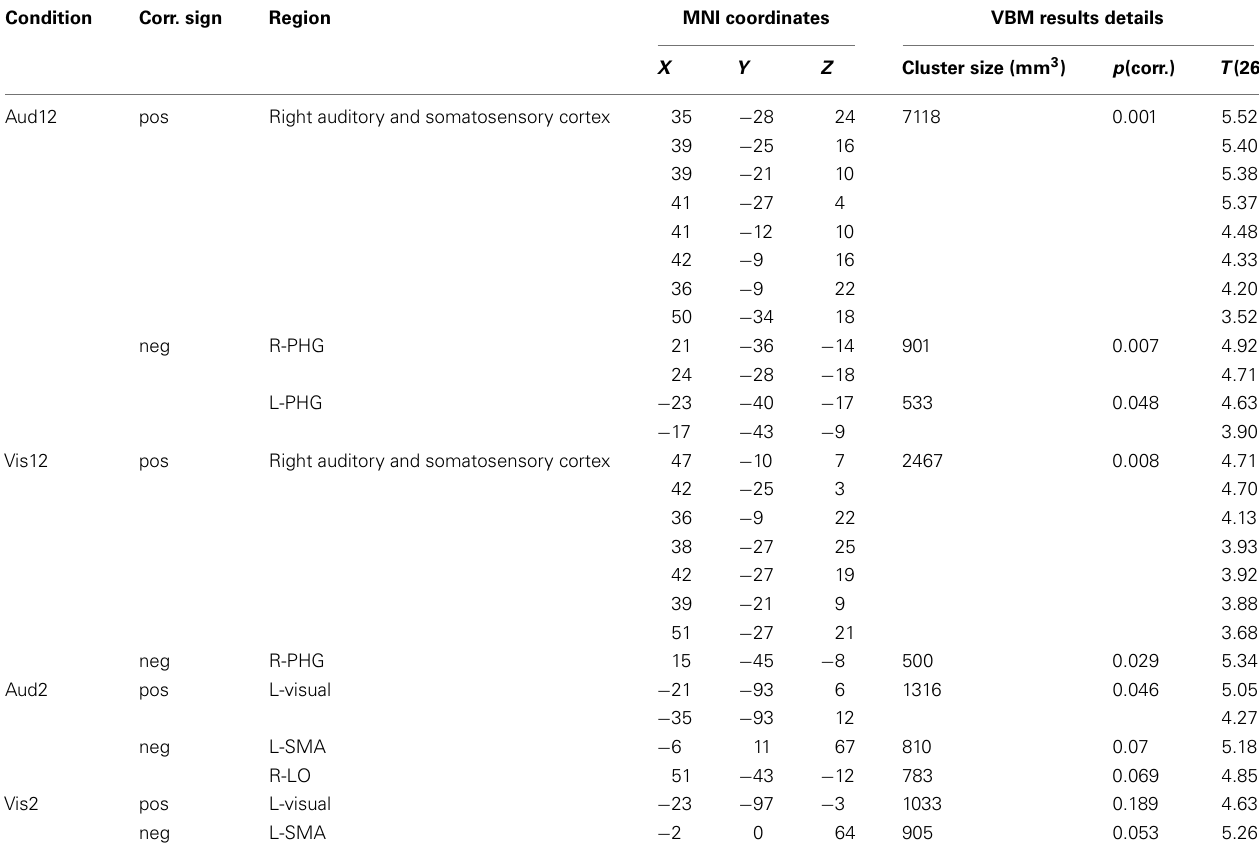
Table 1 |Anatomical and statistical details of the brain regions where gray matter volume correlated significantly with inter-individual variability in duration discrimination ability. Condition Corr.